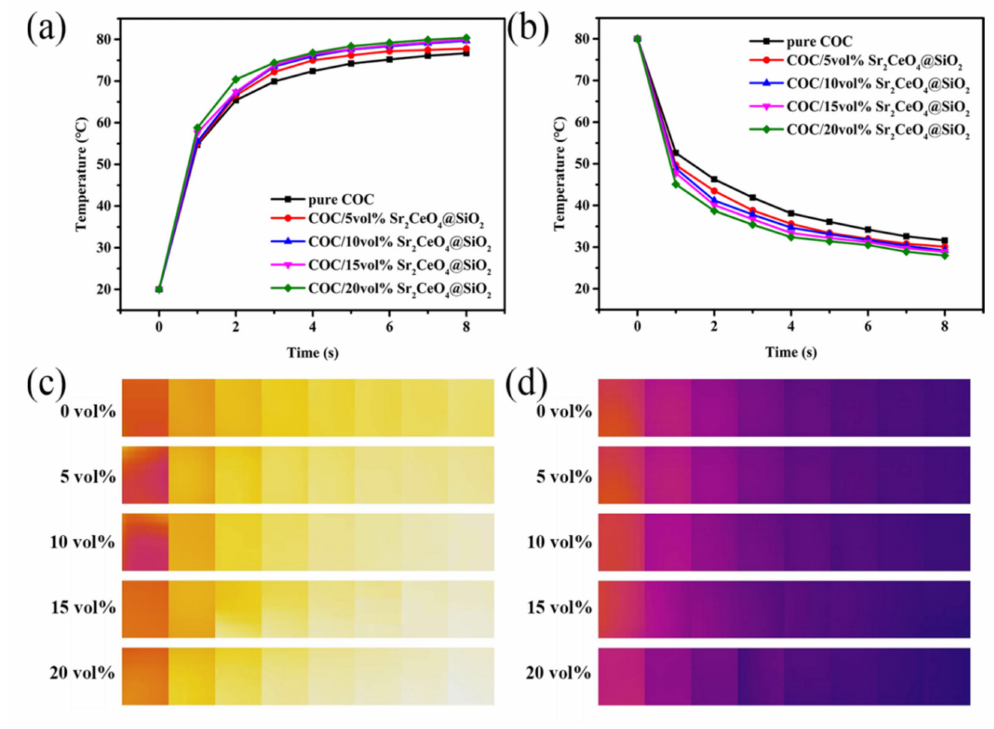
Figure 7. The average temperature change in the samples ( a ) during the heating process; ( b ) during the cooling process; the thermal infrared imaging of the samples ( c ) during the heating process; ( d ) during the cooling process.